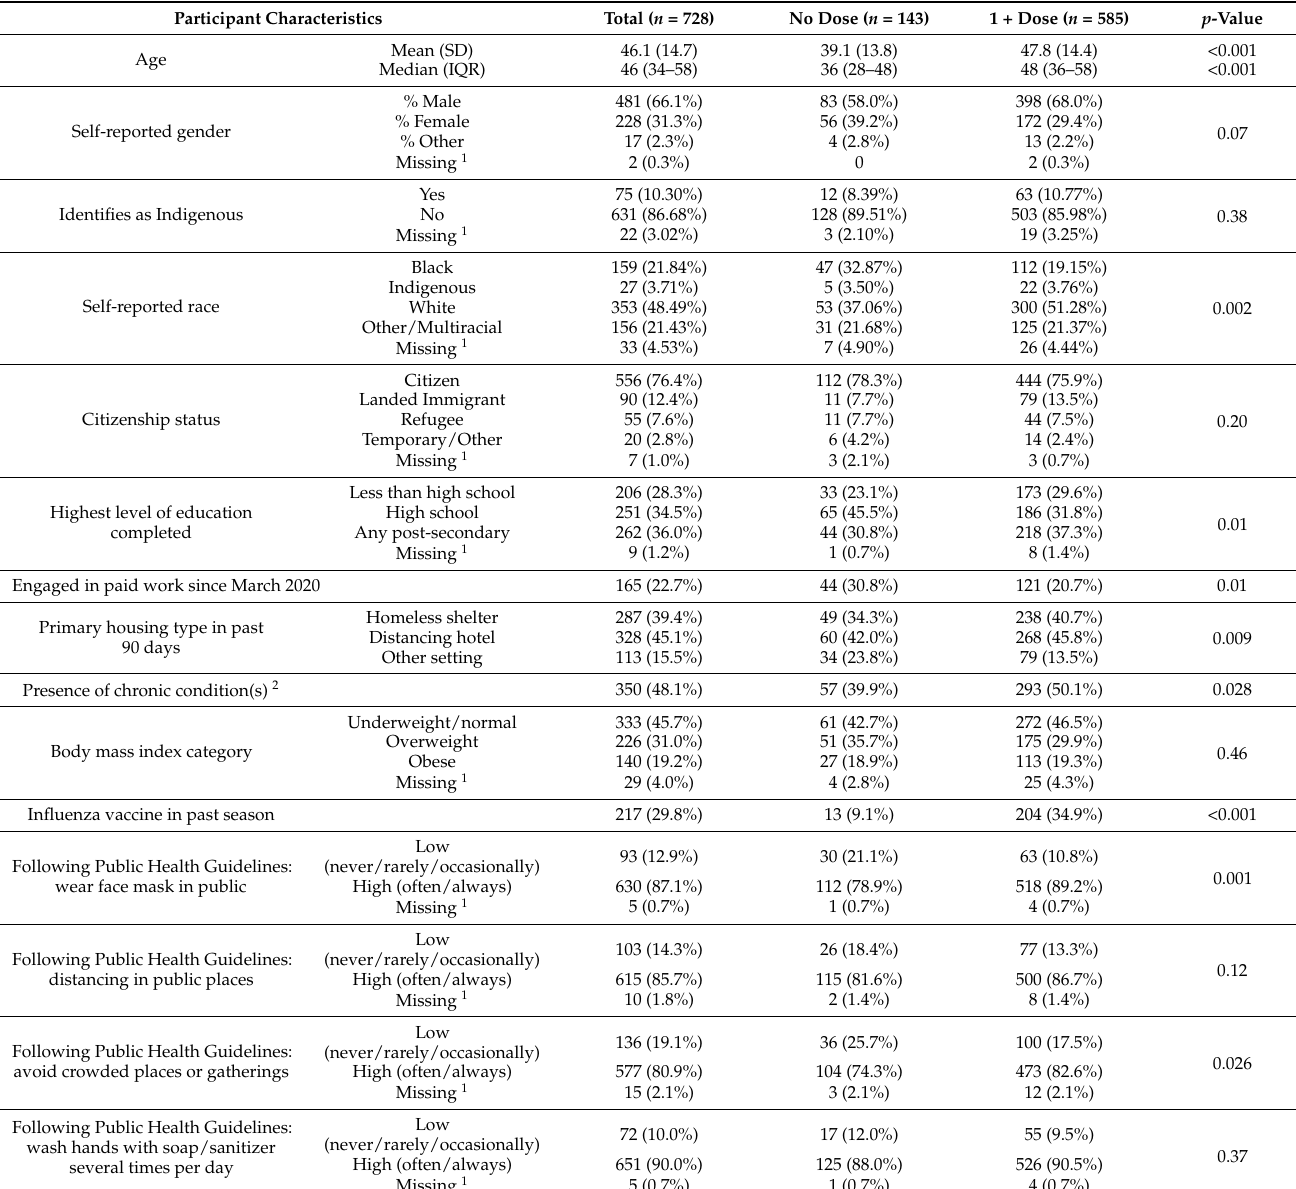
Table 1. Ku-gaa-gii pimitizi-win participant characteristics at baseline, overall and by vaccination